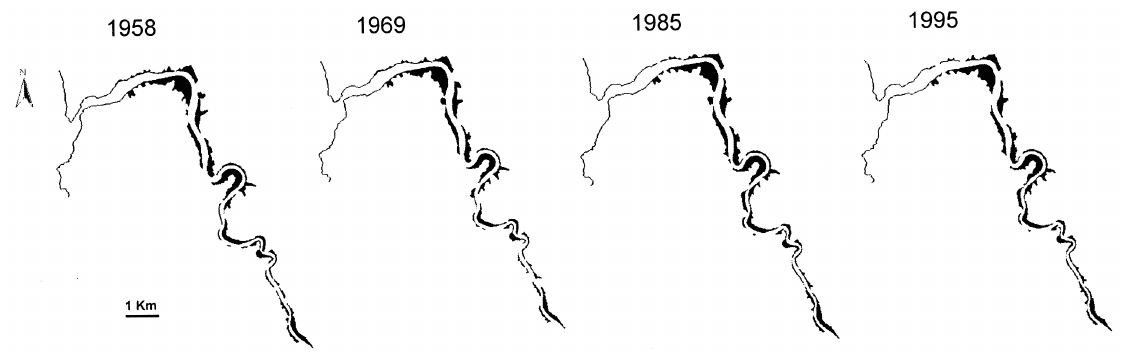
Fig. 6. Salt marsh distribution in the Mira